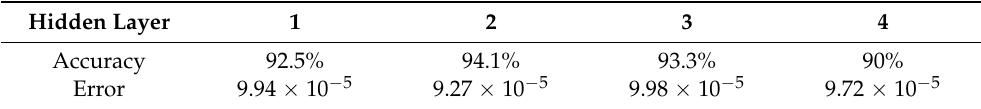
Figure 5. Time–space feature optimization neural network model principles. As demonstrated in related work, as long as there is a three-layer BP neural network with a hidden layer, any mapping function can be approximated [36]. We compare our neural network model results constrained by time and space features with up to four different hidden layers. It can be seen from Table 6 that the model with 2 hidden layers gave the highest accuracy. Table 6. Error table for different hidden layers. Hidden Layer